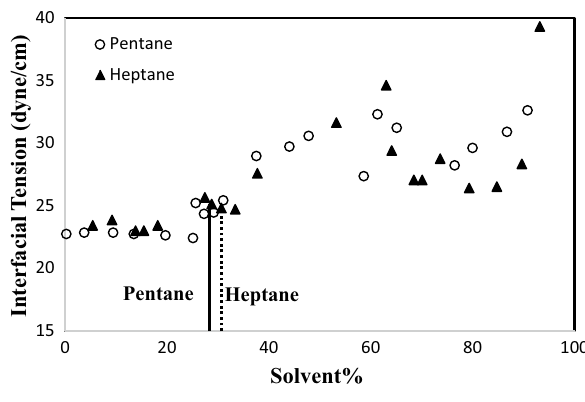
Fig. 17 IFT between water and Sohio oil–precipitant mixture (Mousavi-Dehghani et al.